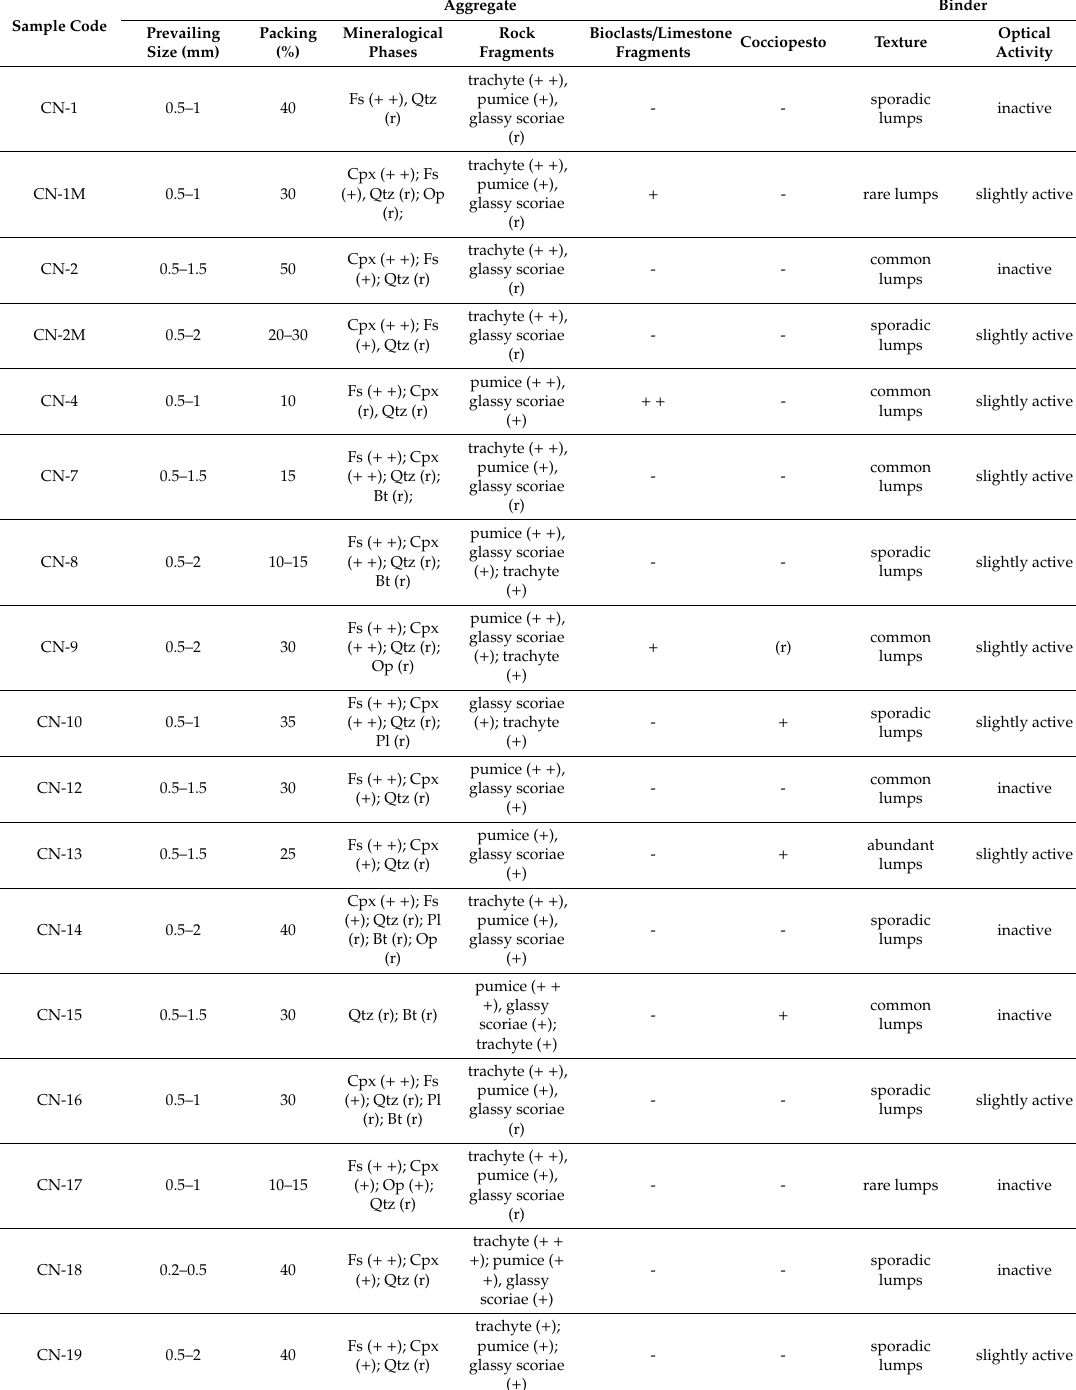
Table 2. Mineralogical and textural features of mortar